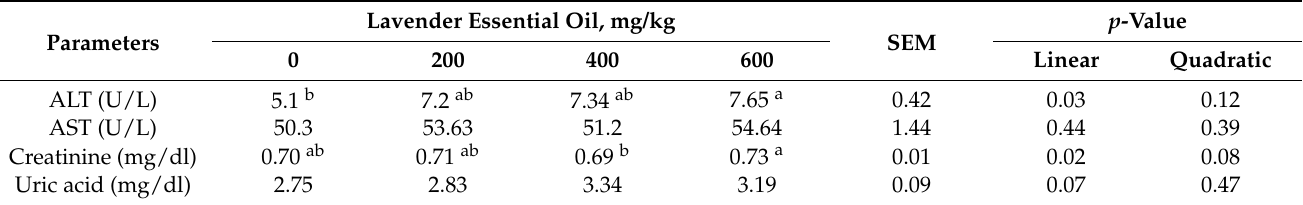
Table 6. Impact of lavender essential oil addition on the liver and kidney function of broiler chickens.